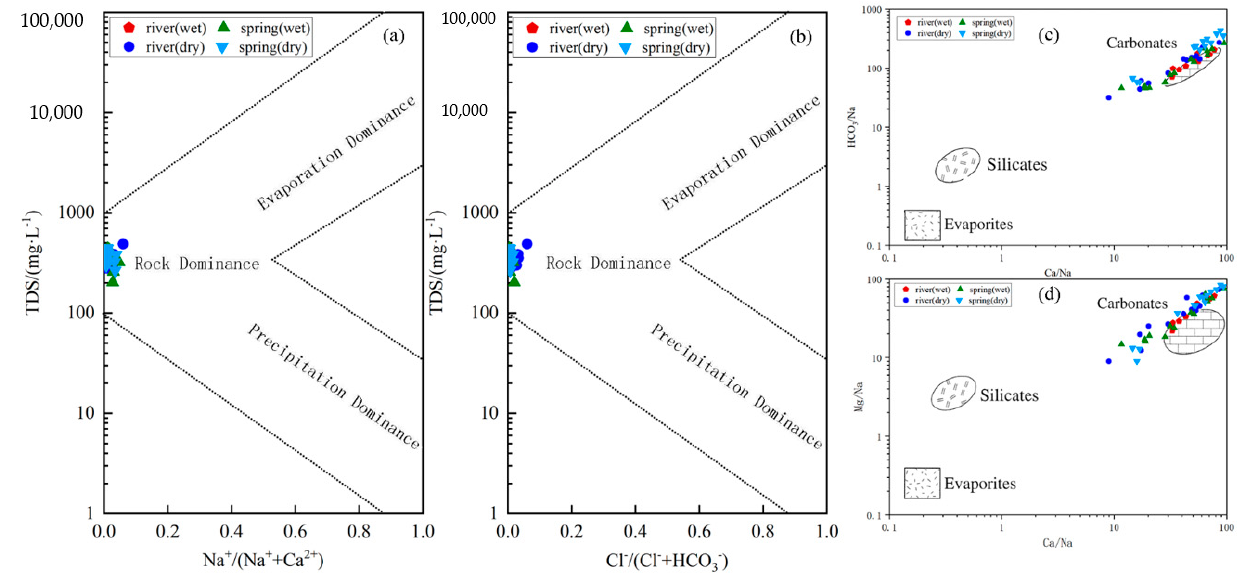
Figure 8. ( a , b ) Gibbs plots, ( c ) scatter diagram of Mg/Na vs. Ca/Na, and ( d ) scatter diagram of HCO 3 /Na vs. Ca/Na.